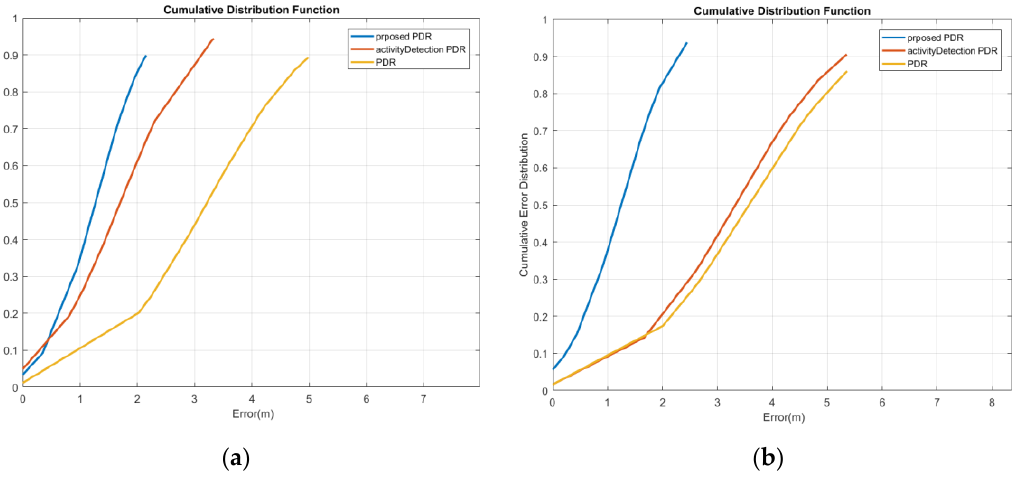
Figure 17. Cumulative error distribution of the texting mode; ( a ) woman; ( b ) man.